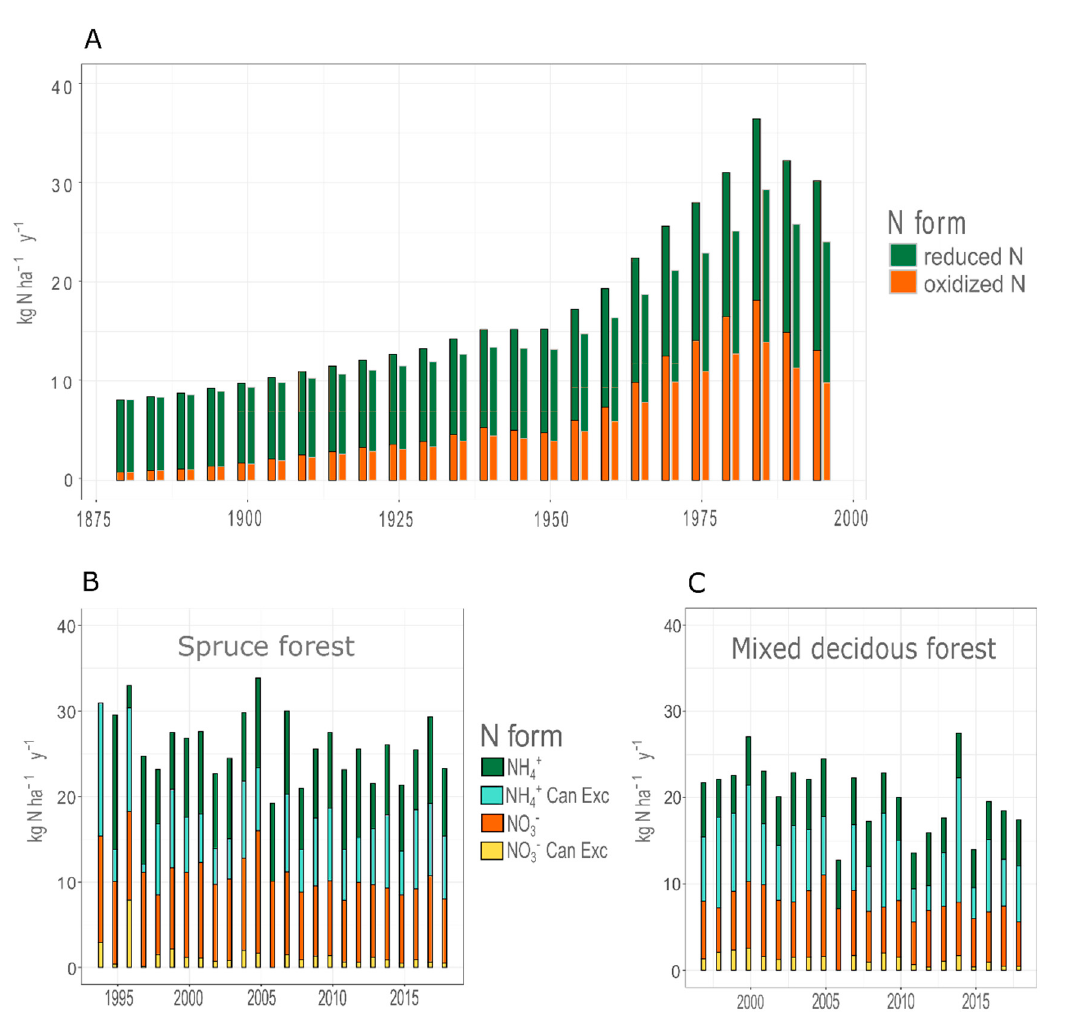
Figure 4. Inorganic N deposition in the study area. ( A ) reconstructed deposition between 1880 and 1990 and measured total NH 4+ -N and NO 3 − -N deposition in the two main forest ecosystems in the catchment: ( B ) spruce dominated forests, and ( C ) mixed deciduous forests. The pairs in A represent spruce dominated (left) and mixed deciduous forests (right). No shades in B and C indicate missing values.